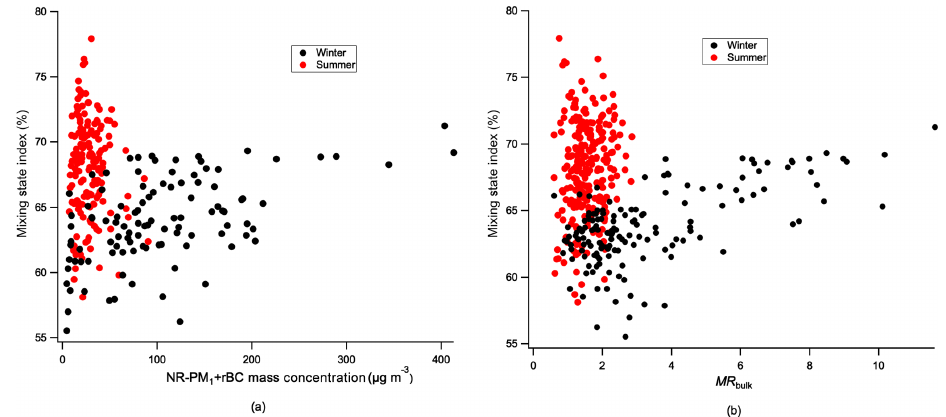
Figure 12. (a) The relationship between NR-PM 1 and rBC mass concentration and the mixing state index. (b) The relationship between MR bulk and the mixing state